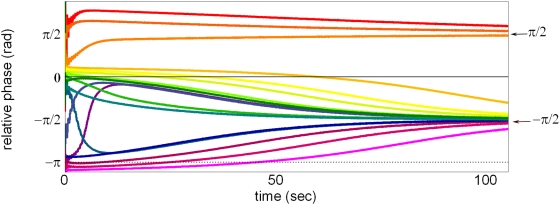
Simulation of the relative phase behavior of a reverse-coupled HKB system.Relative phase approaches either −π/2 or π/2 depending on the initial condition. Except for the reversed coupling, the parameters used are identical and are given in Table I. The shifted attractors are reminiscent of the bi-stability at 0 and π found in the normally coupled HKB system. The convergence of the trajectories toward two attractors at −π/2 and π/2 reflects the (minimal) bistability present due to the choice of parameters.